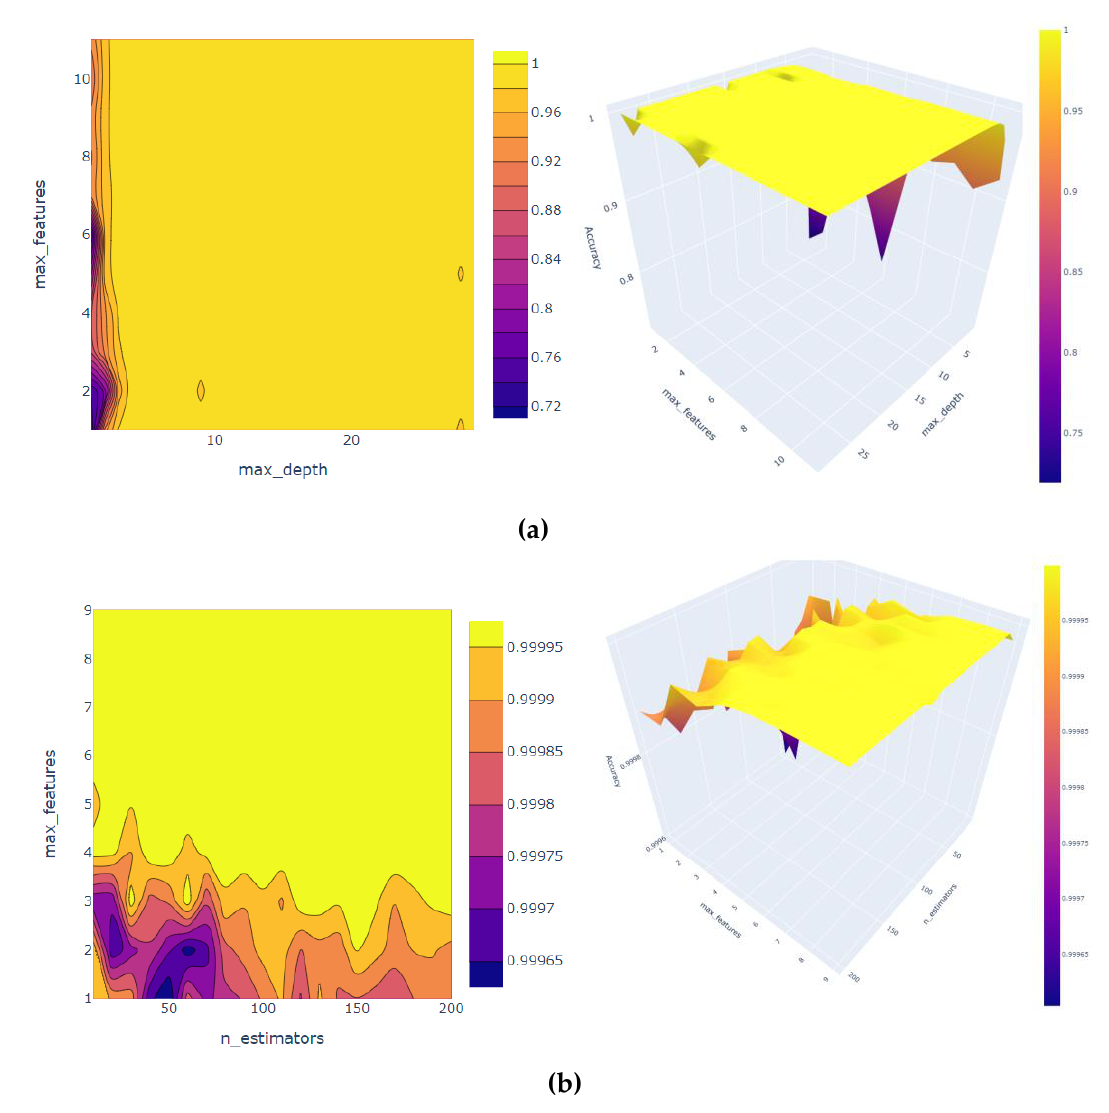
Figure 6. 2D contour and 3D surface plots of hyperparameters tuning for ( a ) DT, and ( b ) RF for target S w . Moreover, different activation functions were used in three hidden layers with six neurons each, and we found out that “tan h ” activation functions performed better. Table 6 presents the evaluation of ANN models with different activation functions, and Figure 7 illustrates their scatter plots. Figure 7 compares the ANN model with the activation functions and shows that they are similar with highly correlated values. The accuracy and error can be determined from Table 5, which indicates that ANN with the tan h activation function had the lowest RMSE value and the highest R 2